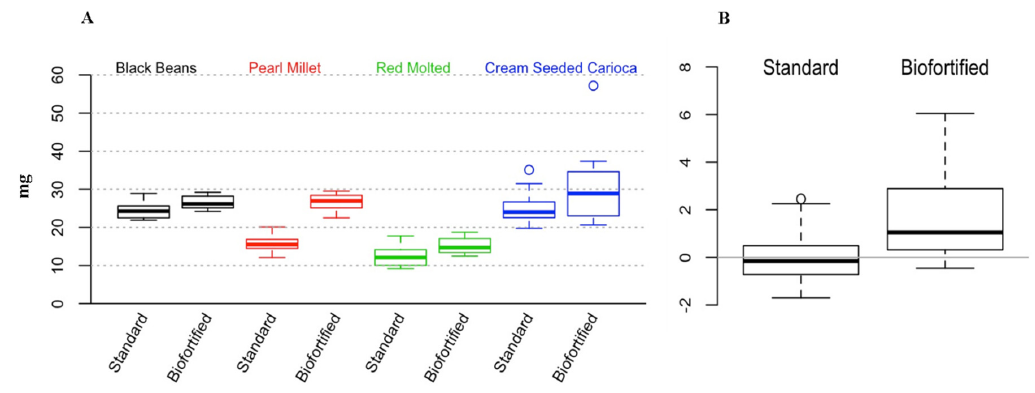
Figure 2. Total body Hb-Fe (mg). ( A ) Experimental treatment differences (mean ± SEM, p < 0.05); ( B ) overall standardized and cross experimental standard vs. biofortified treatment groups.